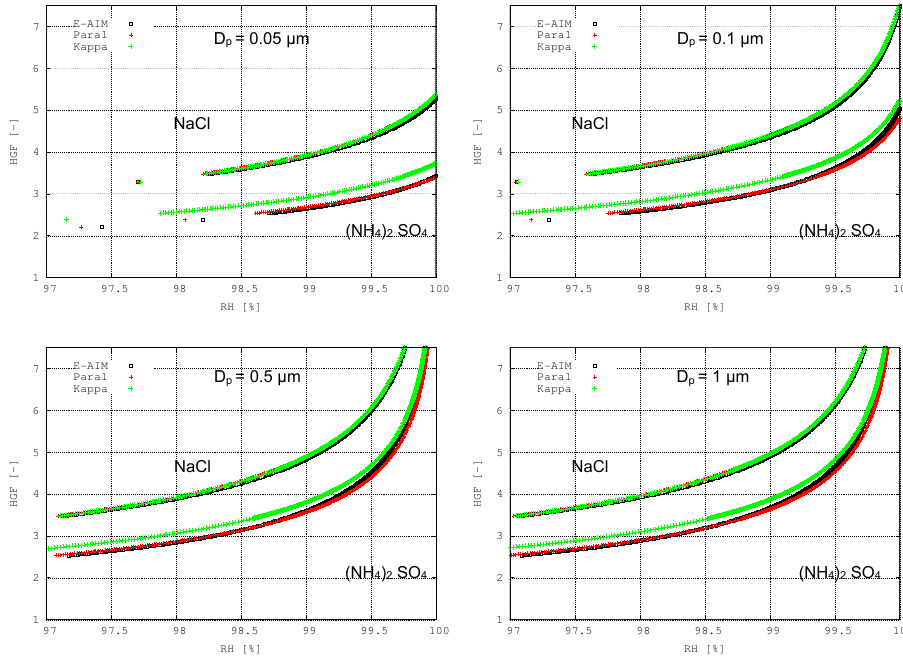
Fig. 4. Same as Fig. 3 but for high RH values within the subsaturated regime, i.e. 97 ≤ RH ≤ 100 [ % ] .